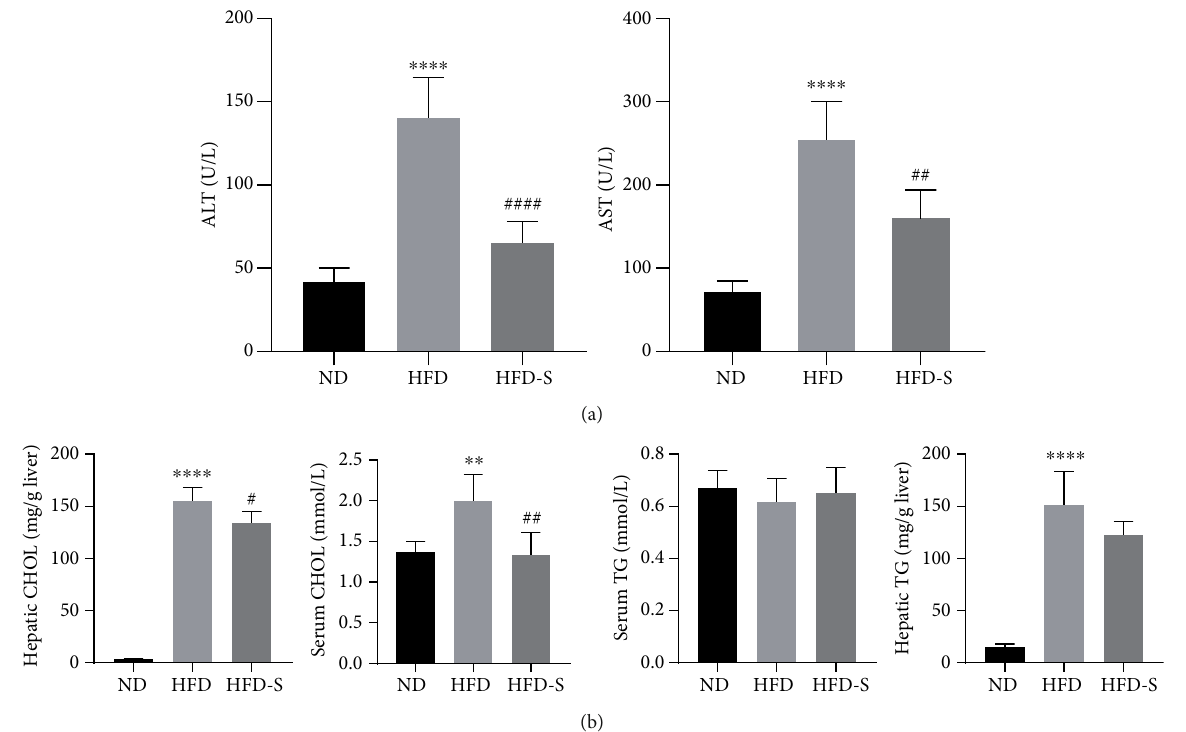
Figure 9: Biochemical indicator results ( n = 5 , mean ± SD ). (a) The levels of ALT and AST in serum. (b) The levels of CHOL and TG in the serum and liver. ∗∗ p < 0 : 01 , ∗∗∗∗ p < 0 : 0001 vs. ND; # p < 0 : 05 , ## p < 0 : 01 , #### p < 0 : 0001 vs.